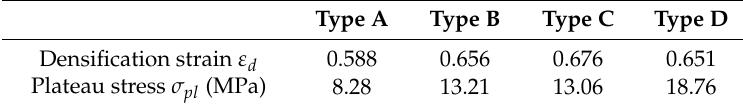
Table 7. The densification strain and plateau stress of four NPR structures.